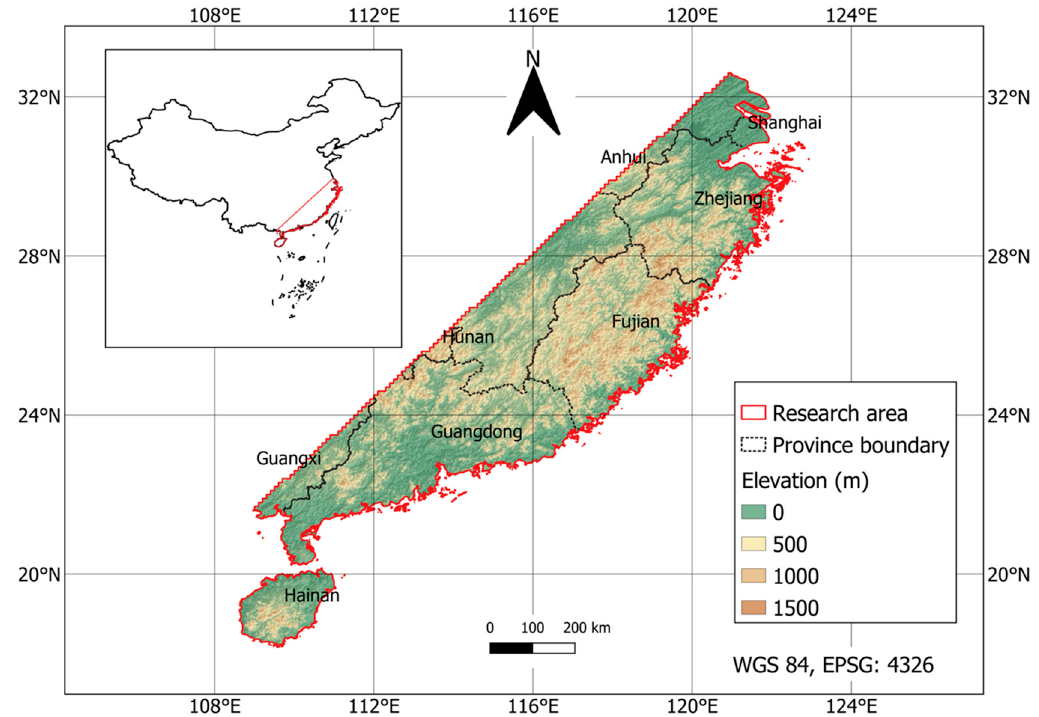
Figure 1. Orographic information of the study region.